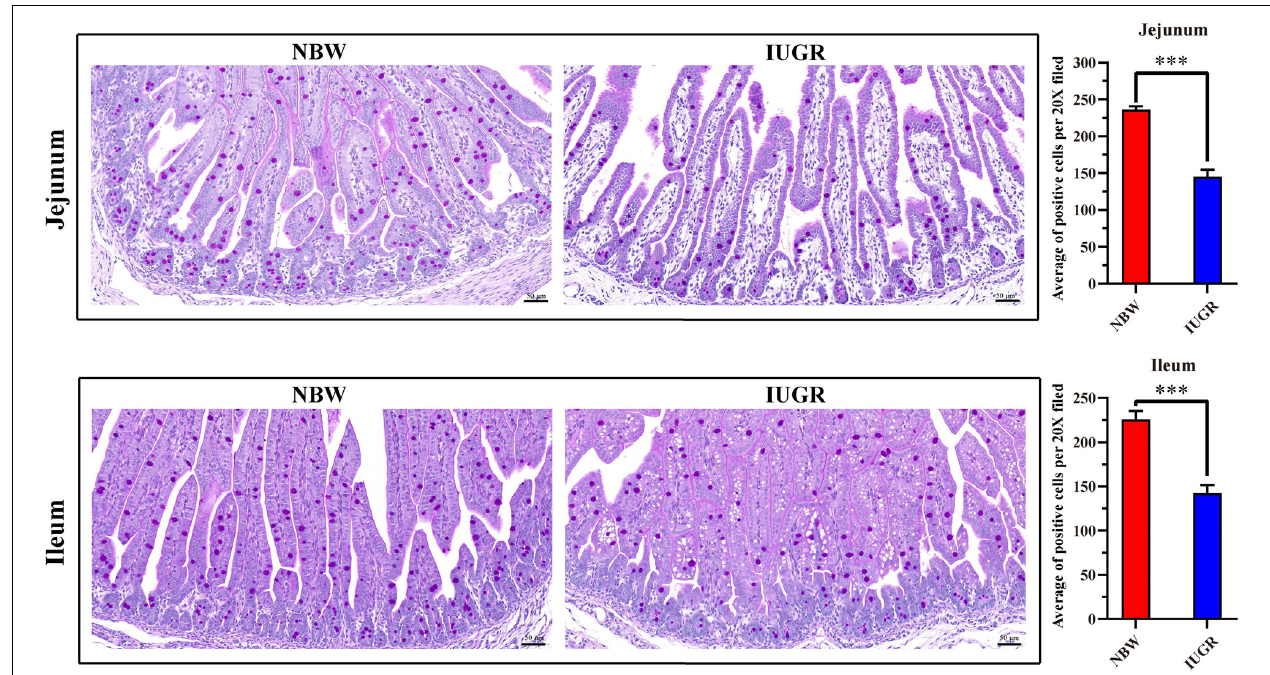
FIGURE 4 | Periodic acid–Schiff staining on jejunum and ileum in NBW and IUGR piglets. Data are shown as mean ± SEM. ∗∗∗ P < 0.001. n = 3 per group. NBW, normal body weight; IUGR, intrauterine growth restriction. Bar = 50 µ m.